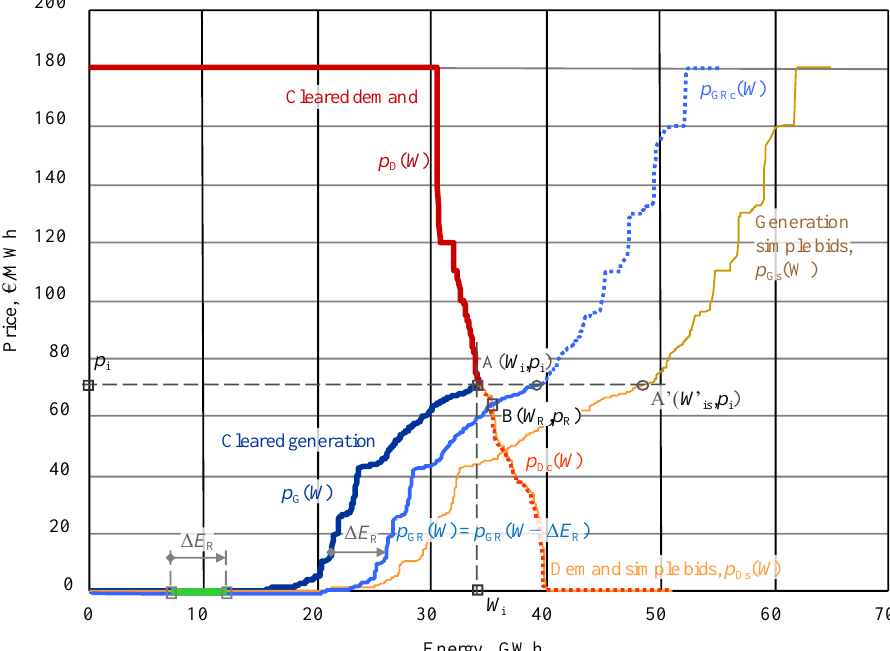
Fig. 3. Merit-order generation, p G (W), and demand, p D (W), curves for a peak hour on a working day in winter corresponding to the Iberian market [13]. Changes in the generation curve and market clearing point due to the integration of an amount of renewable bids, ΔE R , at very low